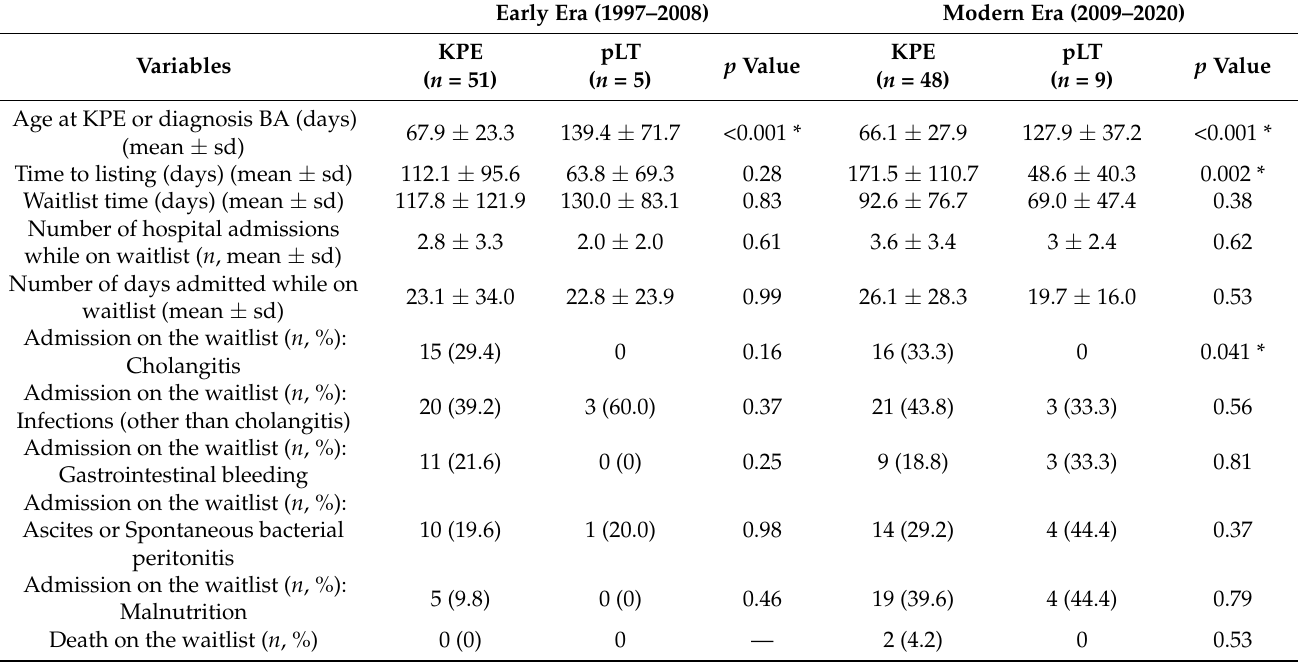
Table 3. Pre-transplant comparison of patients transplanted after KPE or as pLT based on era: demographics, diagnosis of BA and waitlist-related data. Legend: (*) represents a statistically significant